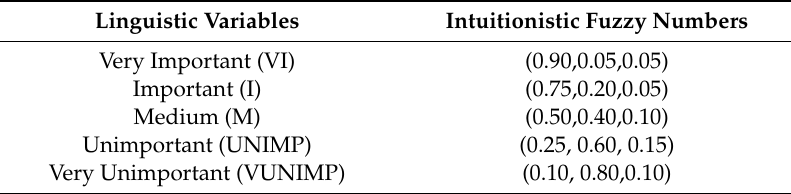
Table 3. Linguistic variables for importance degrees of Decision Makers